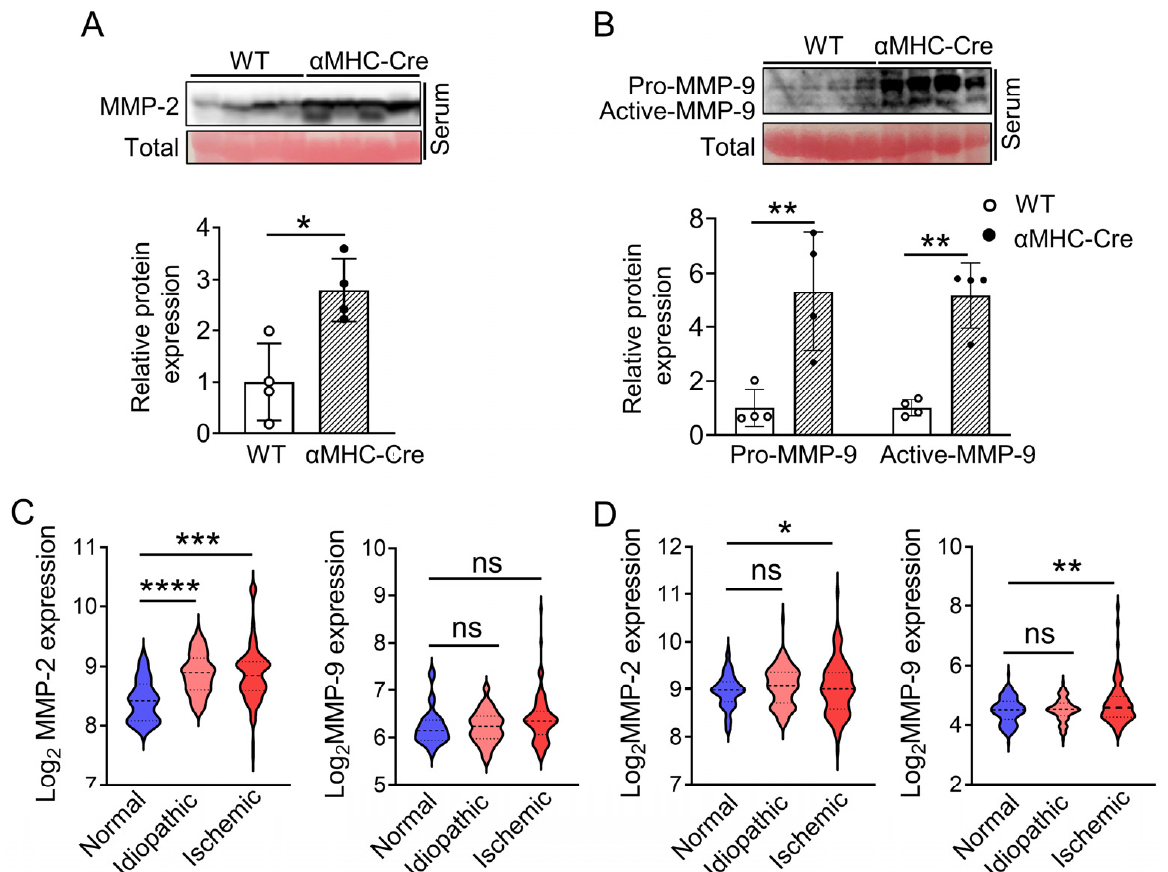
Figure 5 . Elevation of circulating MMP-2 and MMP-9 in α MHC-Cre mice is in consistence with that of patients’ samples with heart failure. ( A and B ) Western blots and quantification of MMP-2 ( A ) and MMP-9 ( B ) protein levels in serum (normalized to total; Red, ponceau S staining) from 6-months-old WT and α MHC-Cre mice. ( C and D ) Relative MMP-2 and MMP-9 mRNA expression in human normal heart tissue or heart failure (idiopathic or ischemic cardiomyopathy) samples based on Gene Expression Omnibus (GEO) database. GEO accession number were GSE5406 ( C ) and GSE57338 ( D ). In GSE5406 dataset: n (Normal: non-failing heart) = 16; n (Idiopathic failing heart) =